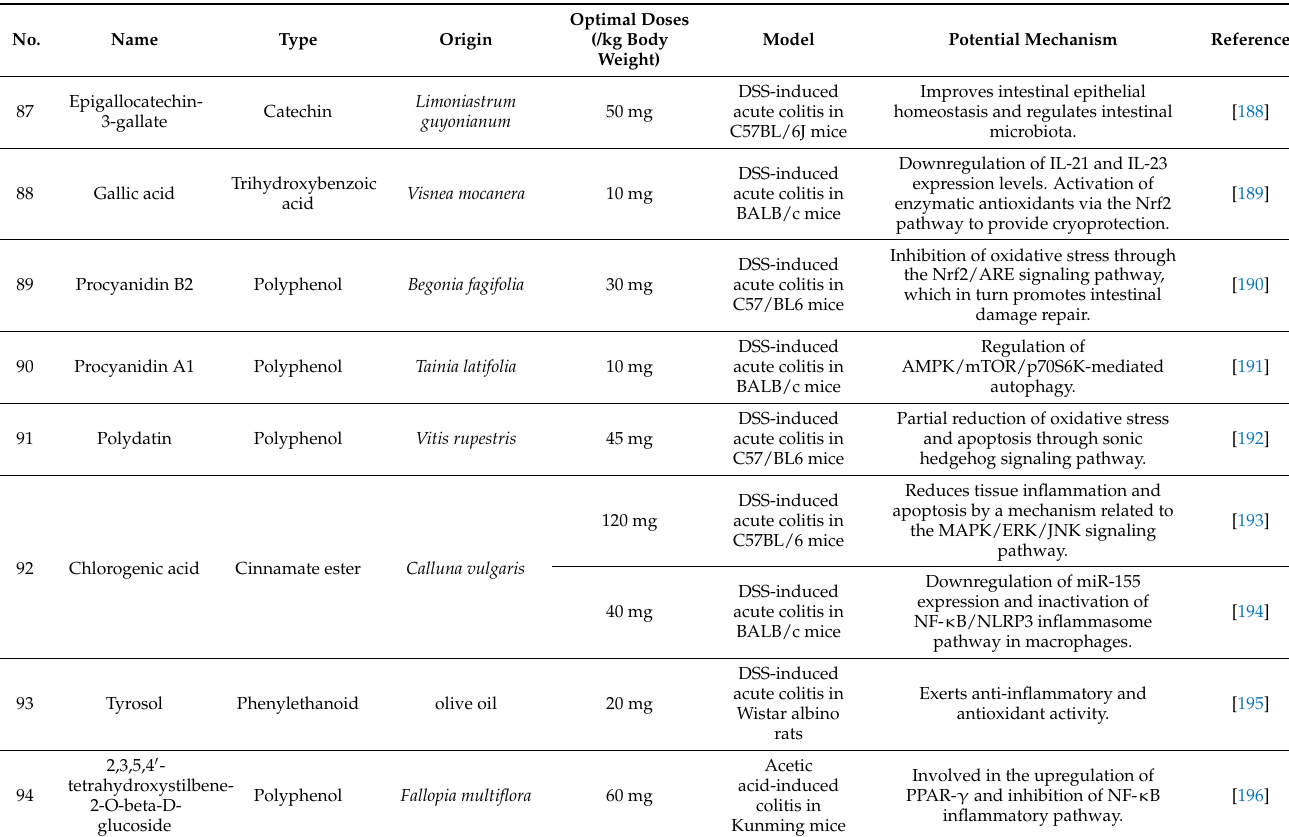
Table 4. In vivo therapeutic effects of polyphenolic compounds on experimental